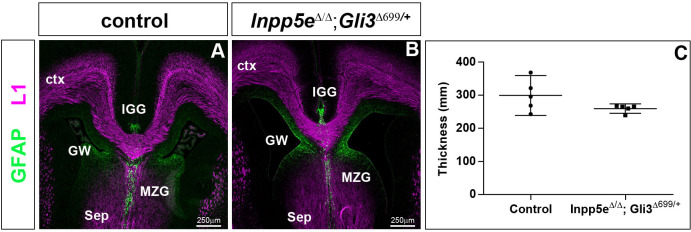
Rescue of corpus callosum formation in Inpp5eΔ/Δ;Gli3Δ699/+ embryos.(A–B) Coronal section through the telencephalon stained with L1 and GFAP to reveal the corpus callosum (CC) and glial cells, respectively. There is no significant difference in the size of the corpus callosum between control and Inpp5eΔ/Δ;Gli3Δ699/+ embryos; the glial wedge (GW), the induseum griseum glia (IGG) and the midline zipper glia (MZG) are formed in their correct position. (C) Quantification of corpus callosum thickness. Statistical data are presented as means ± 95% confidence intervals (CI); Mann Whitney tests; n = 4; Scale bar: 250 μm.